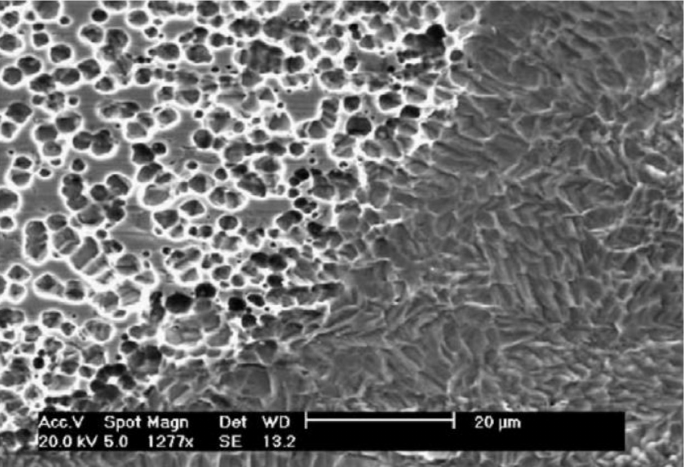
Figure 1. SEM images of stainless steel 316 etched in a mixture of choline chloride–ethylene glycol (1:2) for 10 min at 45 ◦ C at 7.0 V (I 3 − /I − ) (reprinted with permission from ref. [35]; Copyright 2005